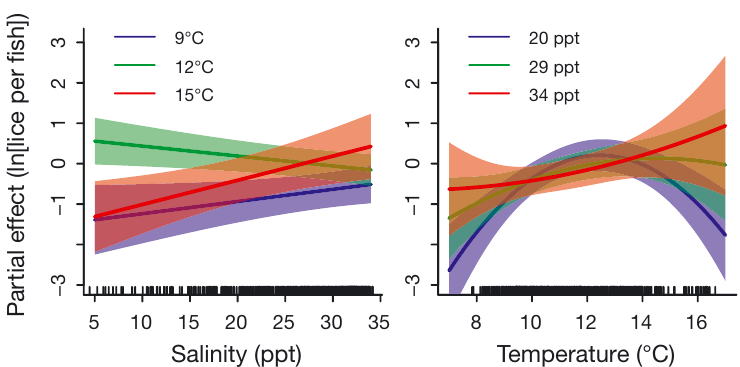
Fig. 7. Estimated non-additive effects of salinity and temperature on ln(lice per fish). The figure shows partial effects with 95% pointwise confidence bands. Estimated salinity effects at 3 representative temperatures are shown in the left-side panel. Estimated temperature effects at 3 representative salinities are shown in the right-side panel. The model also includes infestation pressure as a covariate, which assumes temperature-dependent production of lice larvae and temperature- and salinity-dependent infectivity. The tick marks on the x - axes show the locations of the data. The interaction effect between salinity and the quadratic temperature term is highly significant (p < 0.001) while that between salinity and the linear temperature term is not statistically significant (p = 0.2) optimal. That is, low temperatures were estimated to have the strongest negative effect on lice abundance when salinity was also low, and high temperatures appeared only to have adverse effects when salinity was low (Fig. 7, right panel).